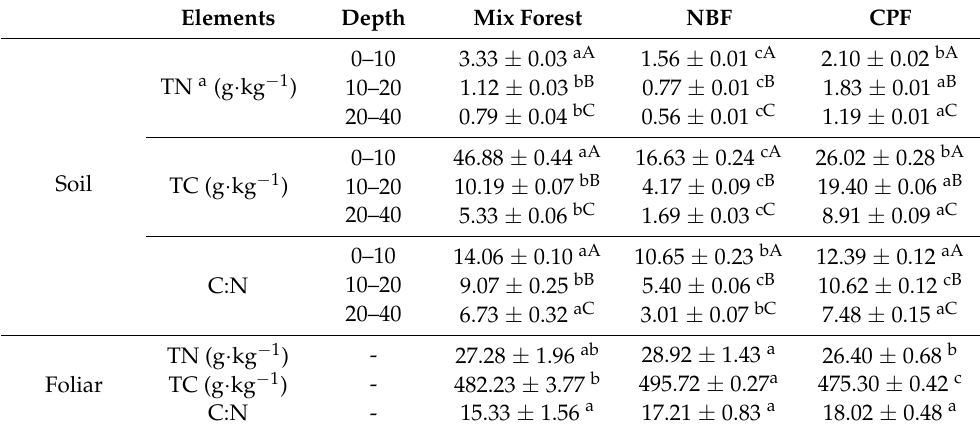
Table 2. Soil and foliar TC, TN content, and C:N ratio in different forest types at different soil depths. Elements Depth Mix Forest NBF CPF